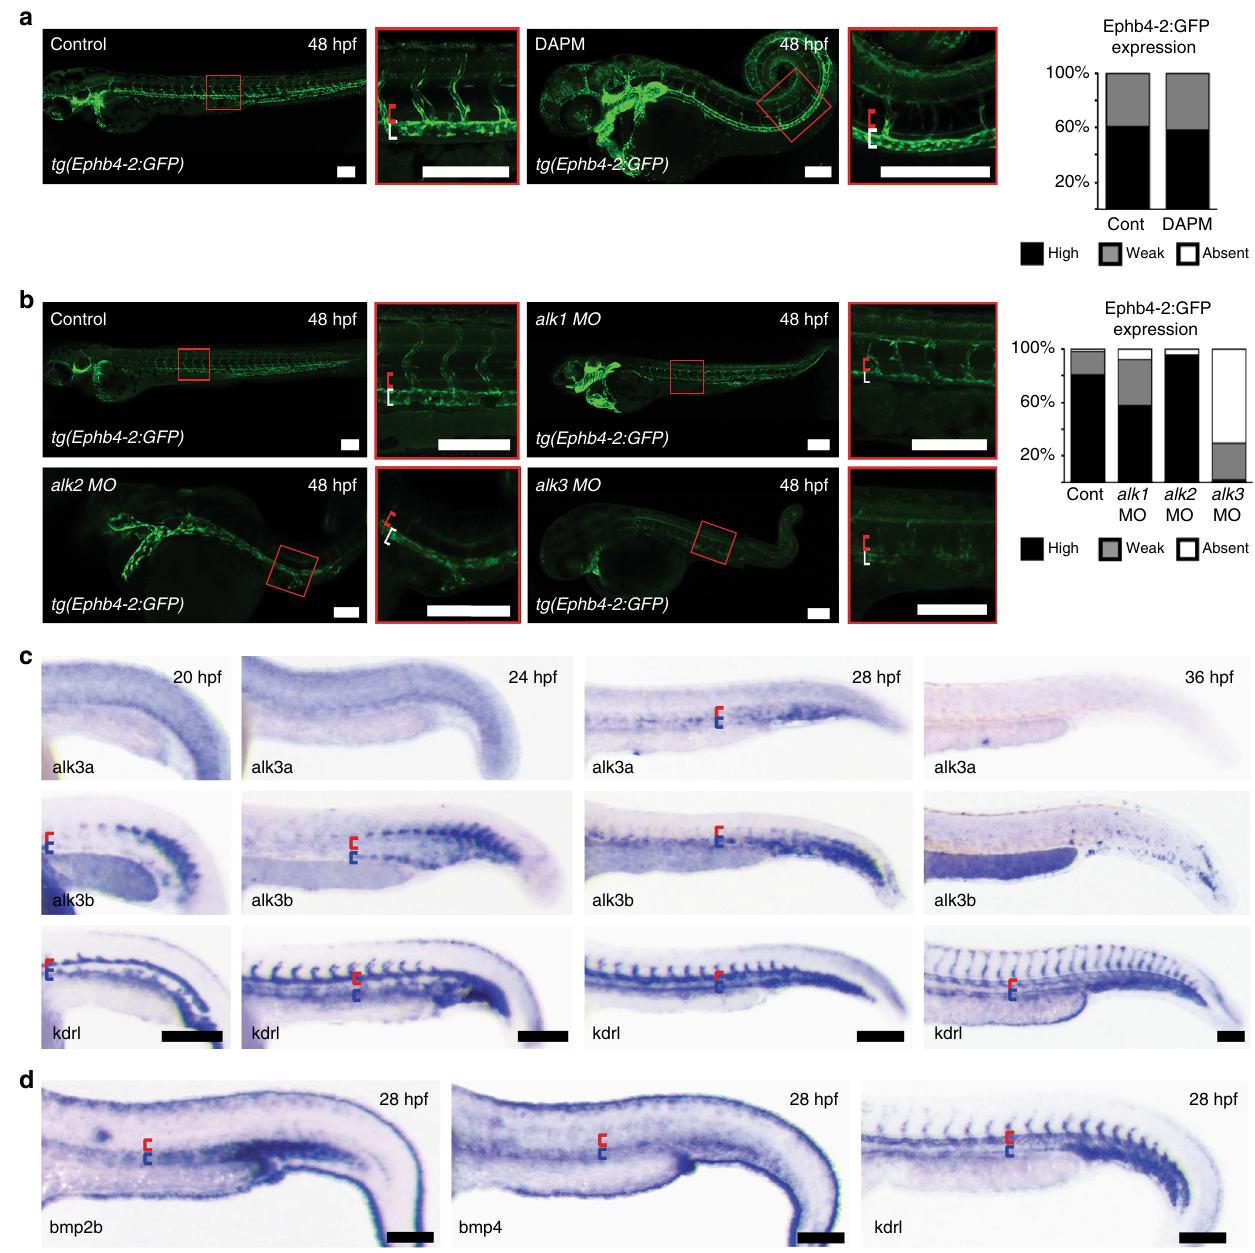
Fig. 8 Notch-independent Alk3a/b signalling is involved in venous identity in zebra fi sh. a Loss of Notch signalling had no effect on the expression of the venous Ephb4-2:GFP transgene in tg(Ephb4-2:GFP) transgenic zebra fi sh. Representative 48 hpf embryos demonstrate similar intensities of vein-speci fi c green fl uorescent protein (GFP) expression in both control and DAPM-treated embryos. Red bracket = dorsal aorta, white bracket = posterior cardinal and ventral vein. Graph depicts observed expression pattern of GFP in tg(Ephb4-2:GFP) embryos for control ( n = 51) and 100 µ M DAPM-treated embryos ( n = 57); black denotes high expression, grey denotes weak. See Supplementary Fig. 12 for Coup-TFII-965:GFP results and controls. b Morpholino (MO)- induced reduction of alk1 and alk2 had little effect on Ephb4-2:GFP expression in 48hpf tg(Ephb4-2:GFP) transgenic zebra fi sh, whereas reduction of alk3a/b resulted in signi fi cantly decreased transgene expression. Representative 48 hpf tg(Ephb4-2:GFP) embryos demonstrate reduced GFP expression after alk3a/b MO injection. Red bracket = dorsal aorta, white bracket = posterior cardinal and ventral vein. Graph depicts observed expression patterns of GFP for control ( n = 51), alk1 MO ( n = 45), alk2 MO ( n = 45) and alk3a/b MO ( n = 48); black denotes high expression, grey denotes weak expression and white denotes no detectable GFP expression. c Whole-mount in situ hybridization for bone morphogenetic protein (BMP) receptors alk3a and alk3b compared to pan-endothelial kdrl in wild-type zebra fi sh embryos at 20, 24, 28 and 36 hpf. Earlier time points can be seen in Supplementary Fig. 13. Both alk3a and alk3b were detected in the axial vein but not in the artery, with greater early expression seen for alk3b . Red bracket = axial artery, blue bracket = axial vein. d Whole-mount in situ hybridization for BMP ligands bmp2b and bmp4 compared to pan-endothelial kdrl in wild-type zebra fi sh embryos at 28 hpf. Both bmp2b and bmp4 showed stronger expression around the axial veins comparative to the dorsal artery. Red bracket = axial artery, blue bracket = axial vein. All scale bars represent 100 μ m. See also Supplementary Figures 12 –